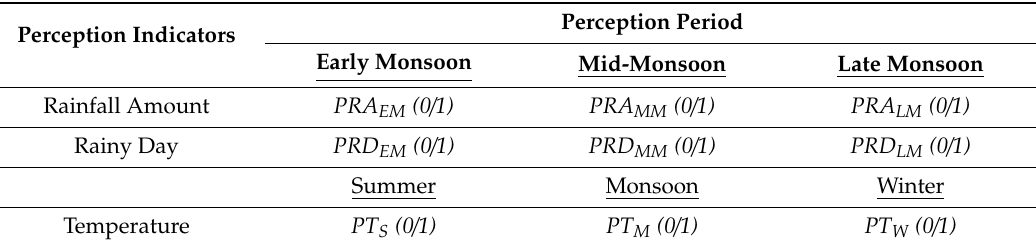
Table 1. Scoring method on farmer’s